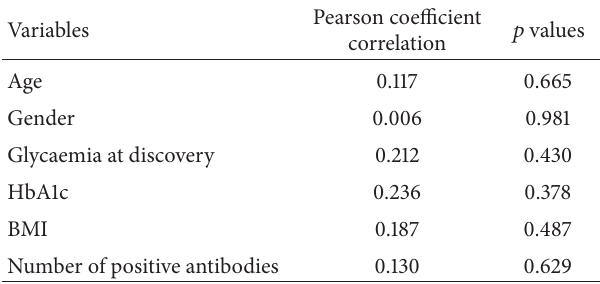
Table 3: Correlations between miR-375 concentration in sera and clinical and biological parameters of the T1D